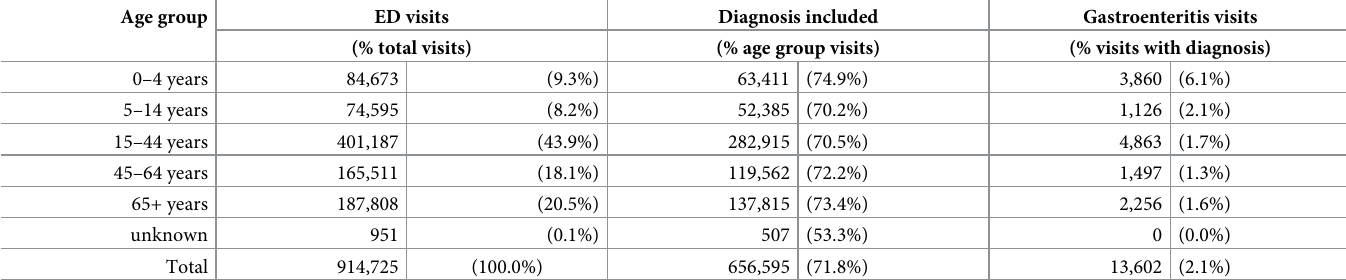
Table 2. Emergency department (ED) visits, those including diagnosis coding and those identified as gastroenteritis, by age group during the post-RV period from 1 July 2013 to 3 July 2016. Age group